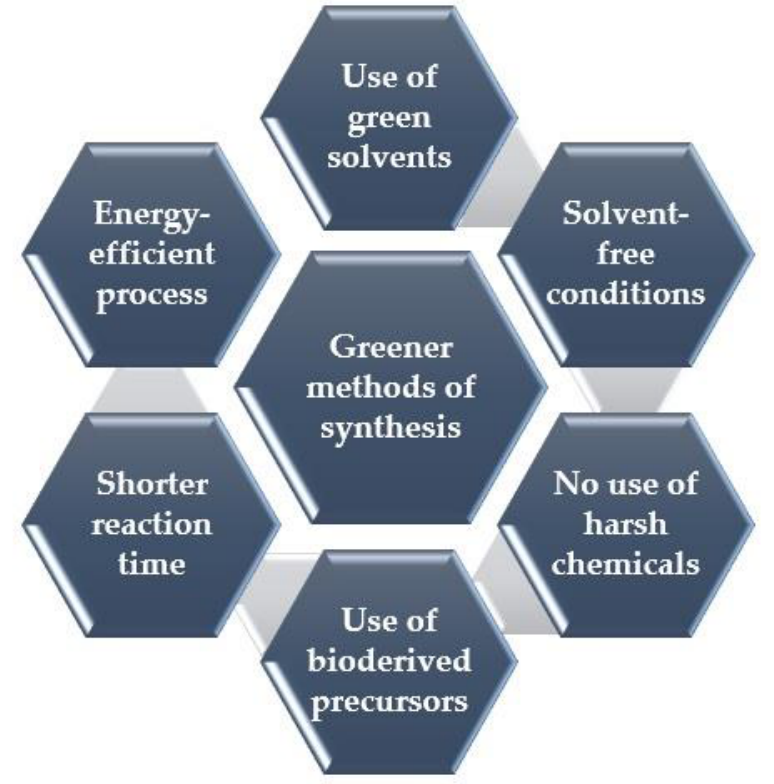
Figure 3. Salient attributes of a “greener” synthesis Figure 3. Sali ent attributes of a “greener” synthesis method.